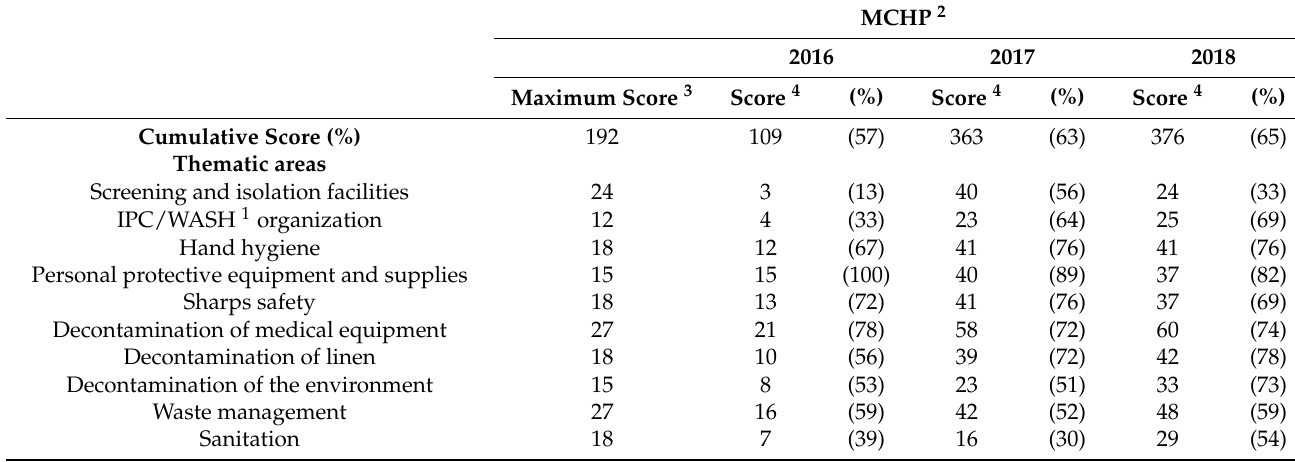
Table 4. Average yearly compliance in relation to scores on a National IPC/WASH 1 assessment tool in Maternal and Child Health Posts, Kenema district, Sierra Leone (2016–2018).